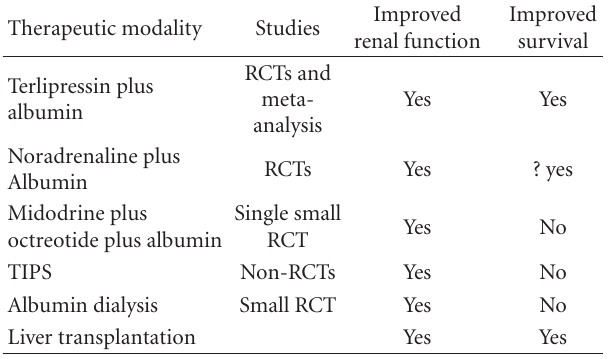
Table 1: Diagnostic criteria for hepatorenal syndrome. Modified criteria for diagnosis of hepatorenal syndrome